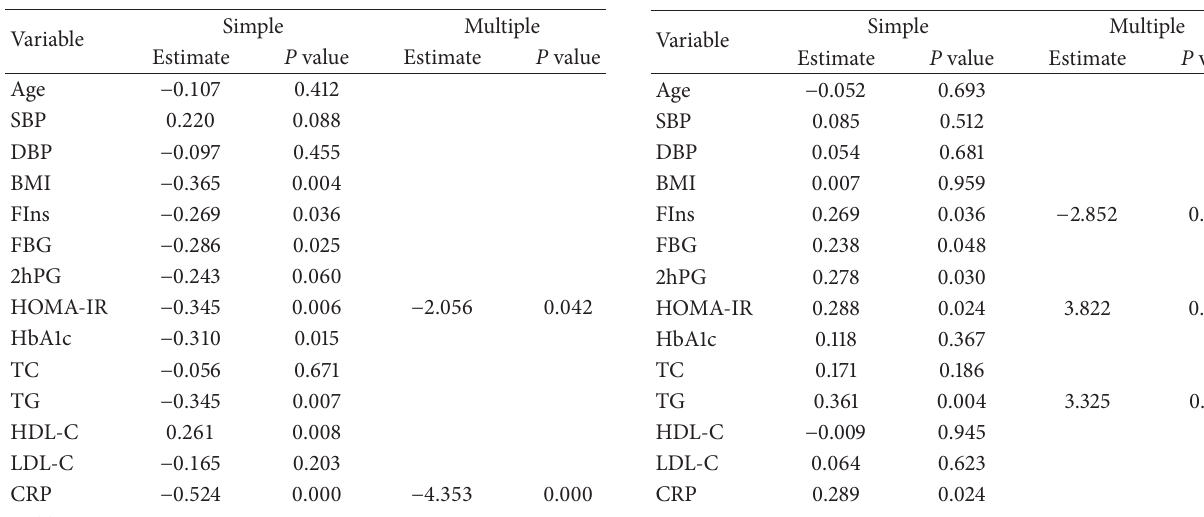
Table 2: Correlation analysis of obestatin and various metabolic parameters.